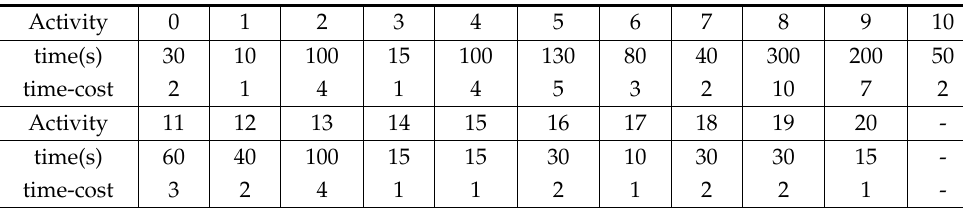
Table 3. Tasks for sinus surgical navigation